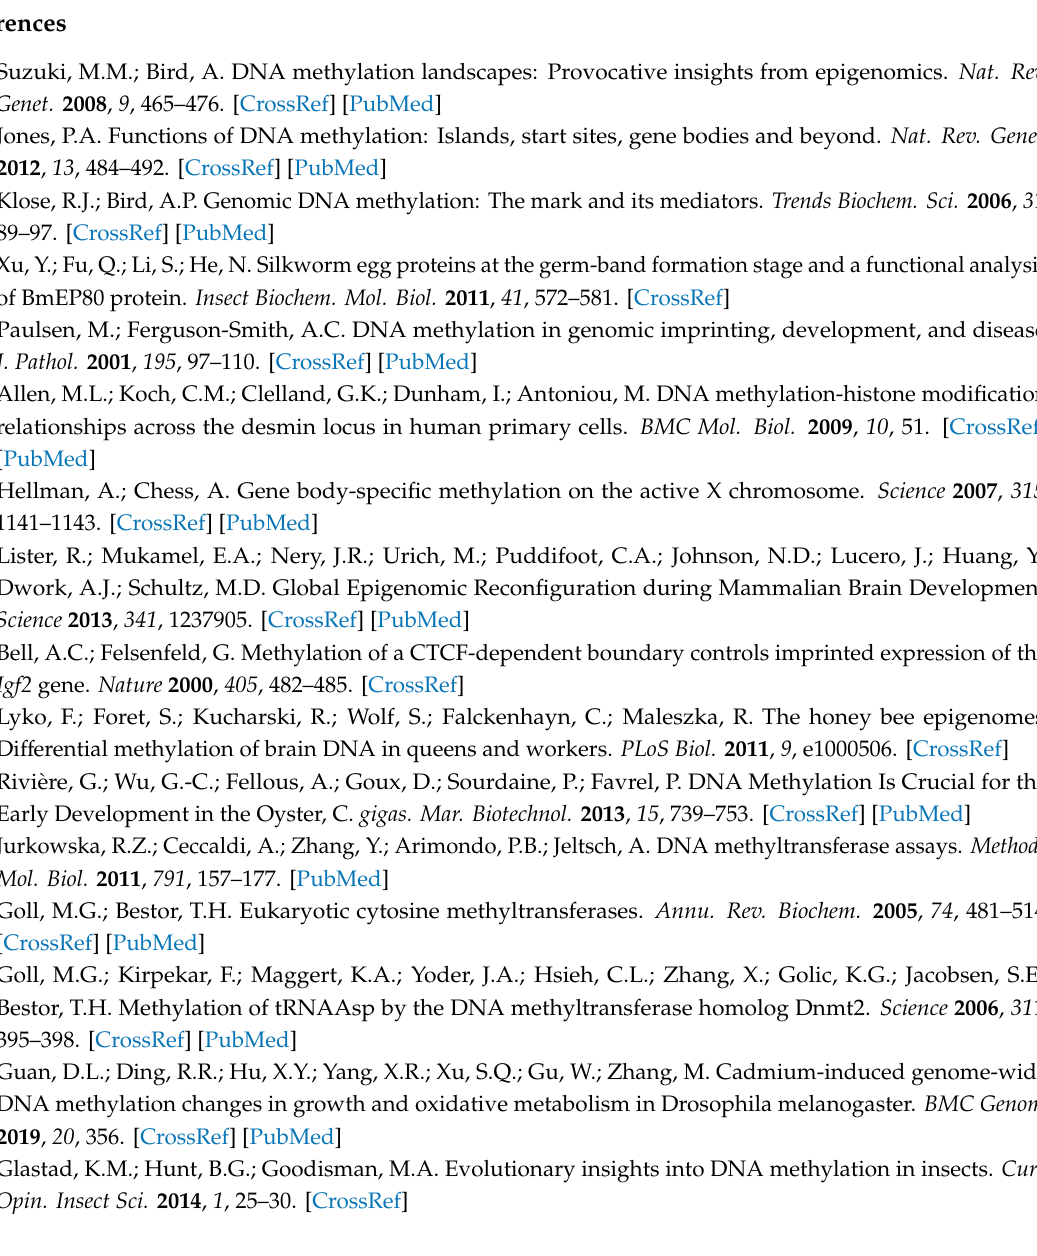
Figure S1: Percentage methylation levels of positively and negatively correlated genes in gene bodies, 2 kb upstream and downstream regions. Table S1: Primers used for PCR studies. Table S2: Details of 1733 di ff erentially expressed genes (DEGs). Table S3: Bisulfite sequencing summary. Table S4: DMPs located in DMRs. Table S5: 364 genes showing significant di ff erences in methylation and protein expression levels in diapause-terminated eggs when compared with diapause-destined